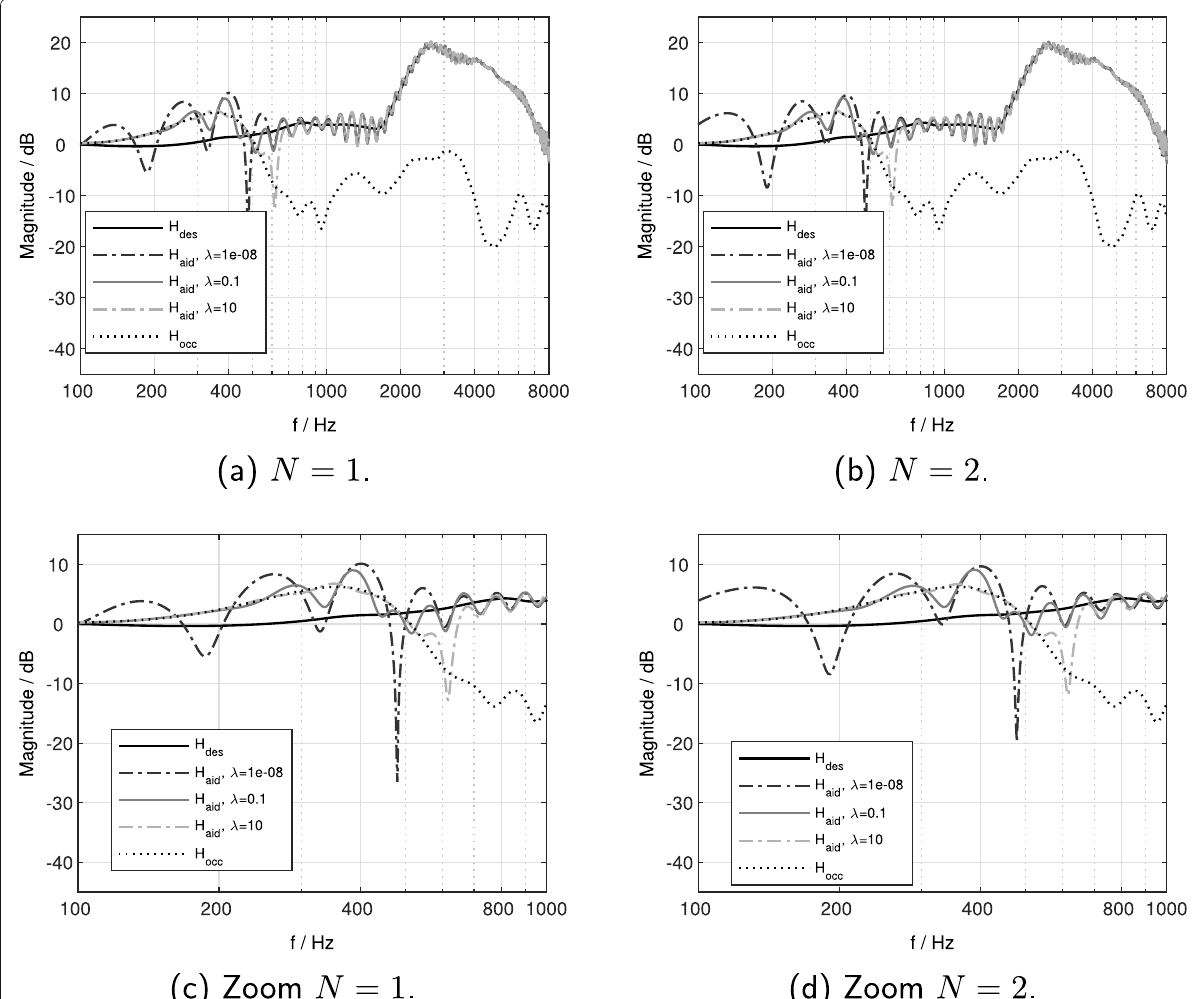
Fig. 5 Magnitude responses of the occluded ear transfer function H occ ( q ) , the desired open ear transfer function H des ( q ) and the aided ear transfer function H aid ( q ) for different values of λ for N = 1 and N = 2 loudspeakers. ( β = 1, d G = 96 and G 0 =